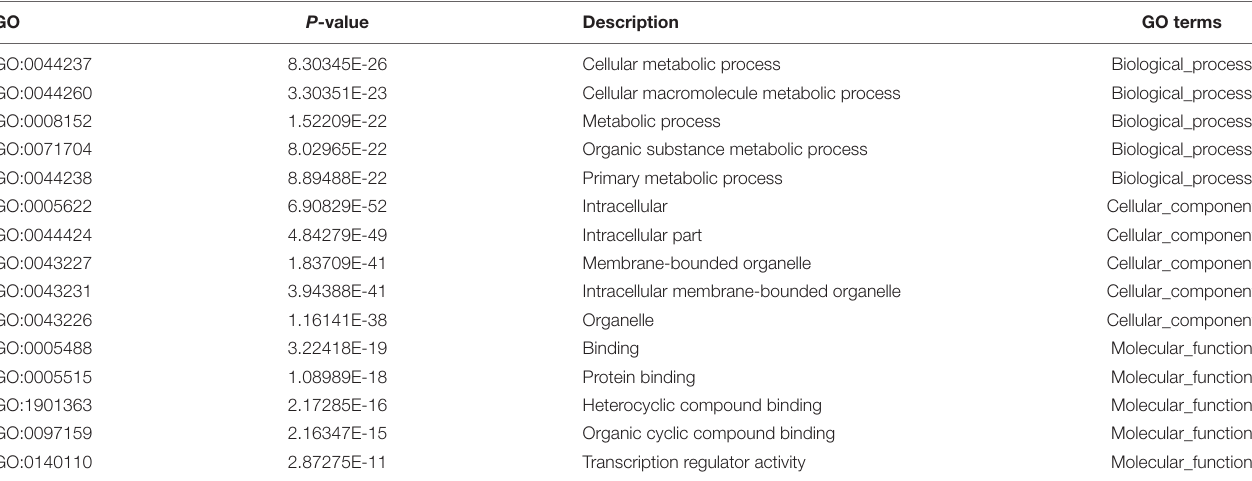
TABLE 2 | The top five (ranked by P -value) BP terms, CC terms, and MF terms. GO P -value